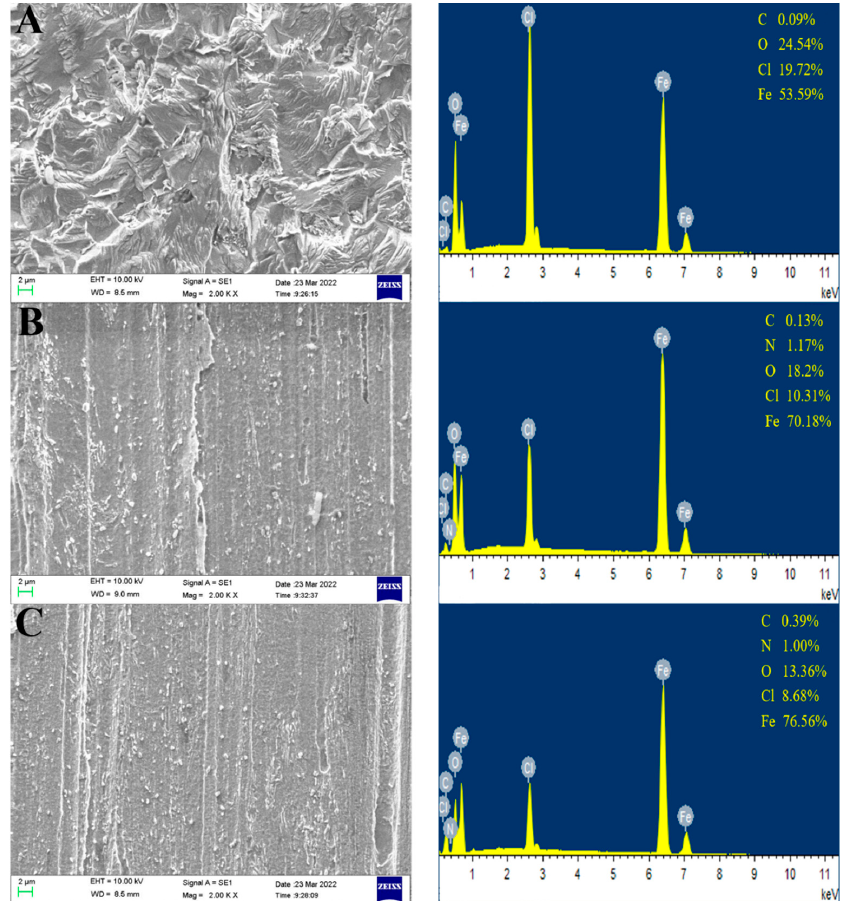
Figure 8. SEM micrographs and their corresponding EDS analysis of N80 steel after 2 h immersion in 1 M HCl solution: ( A ) without inhibitors; ( B ) presence of 300 ppm of MPO; ( C ) presence of 300 ppm of MPPO.